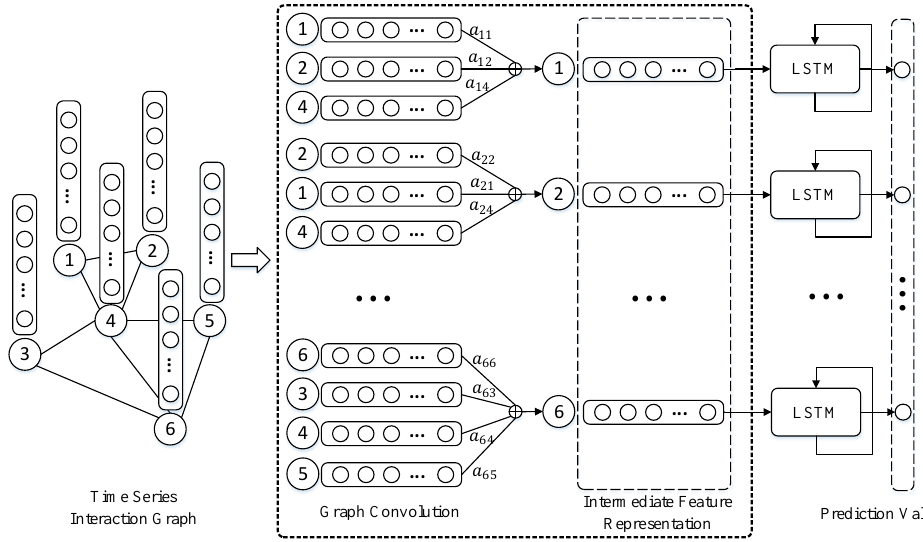
Figure 4. Implementation details of the prediction